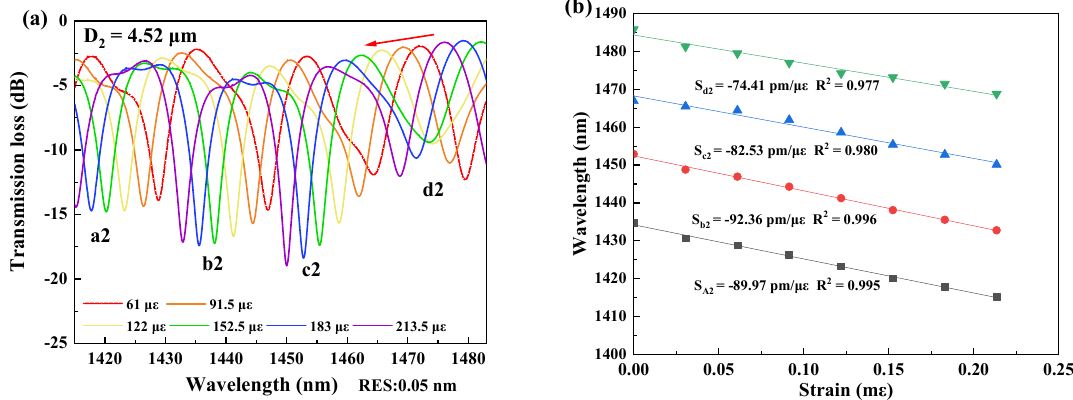
Figure 4. ( a ) Spectral responses of the interferometer with D 2 = 4.52 μm at the strain ranging over 61–213.5 µε at 1415–1483 nm. ( b ) Linear fitting curves of the dip wavelength shifts and the coefficients of determination R 2 of linear fitting with D 2 = 4.52 μm.